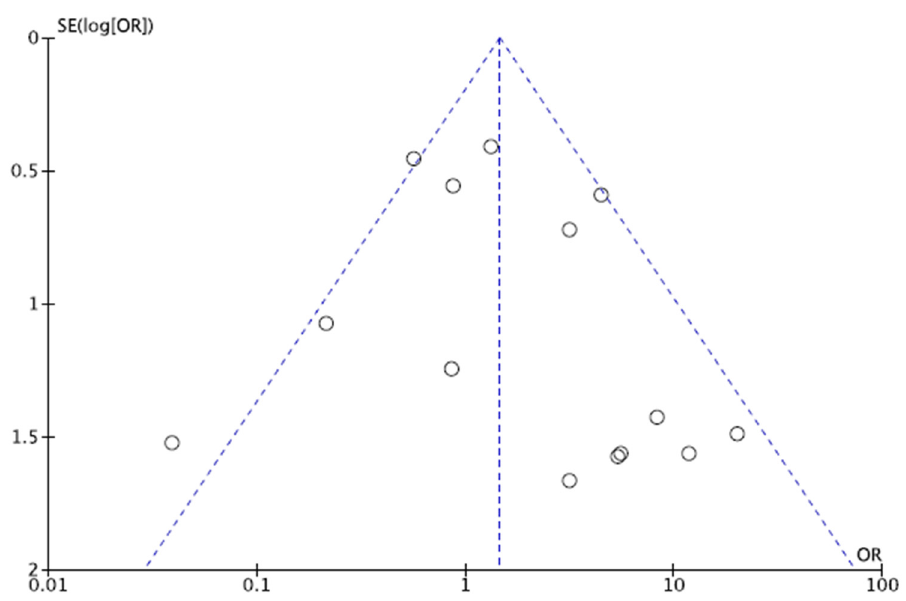
Figure 3. Funnel plot. The funnel plot charted the standard error (SE) of the log odds ratio (Log OR) versus its odd ratio. The degree of asymmetry of the plot is directly proportional to the degree of bias.